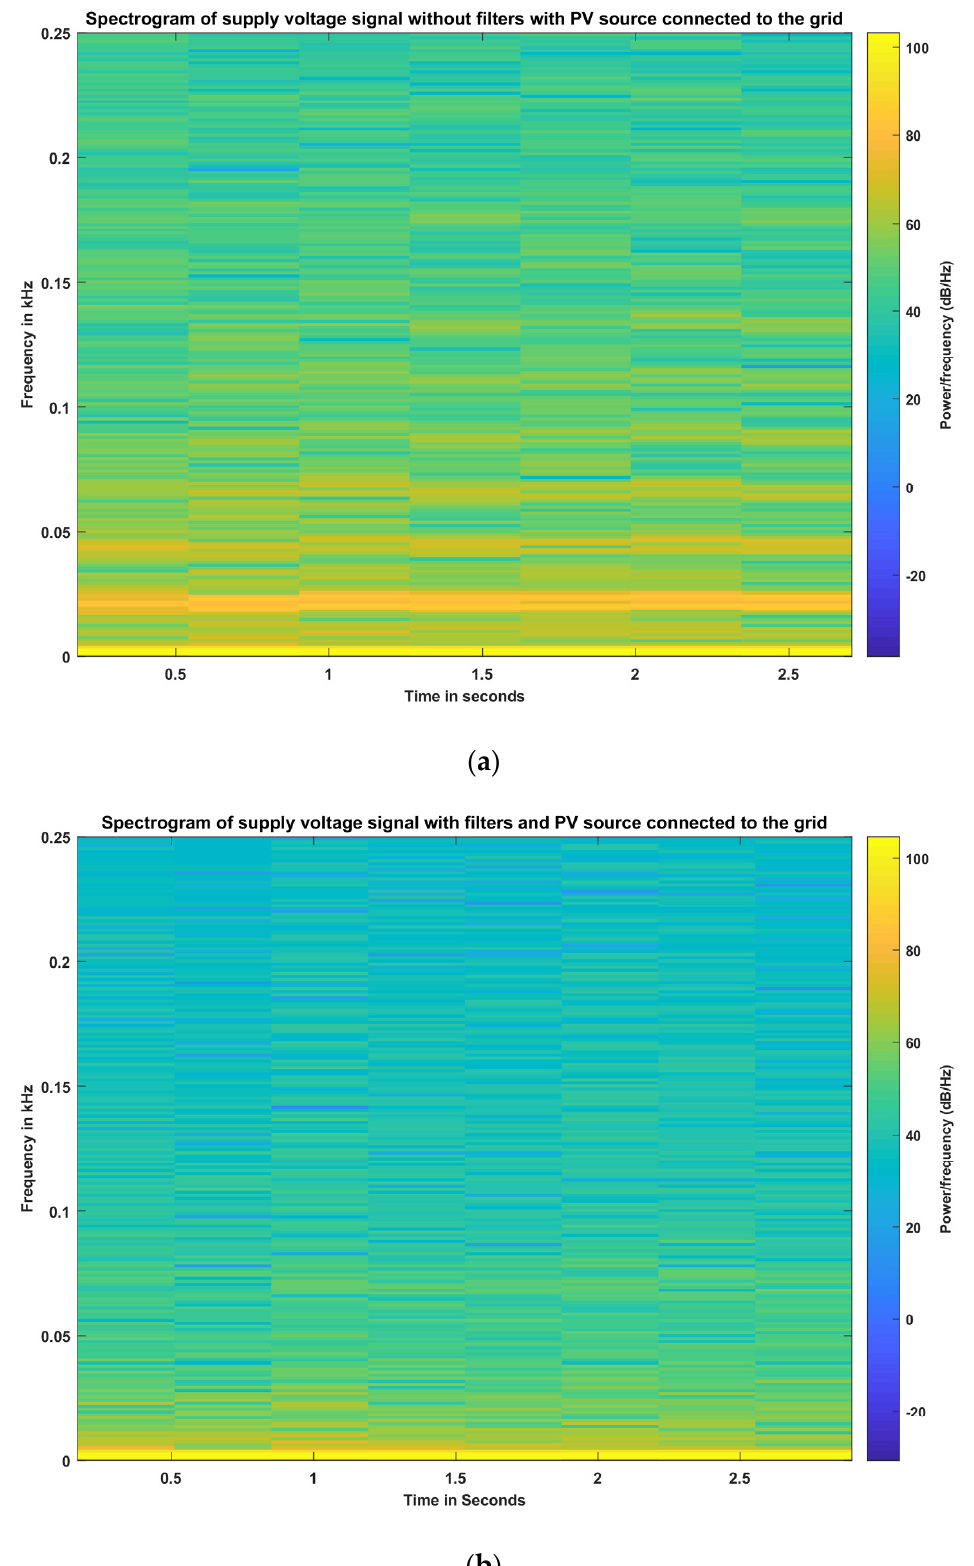
Figure 17. ( a ) Spectrogram after integration of PV source into the system without harmonic filters. ( b ) Spectrogram after integration of PV source into the system with harmonic filters.